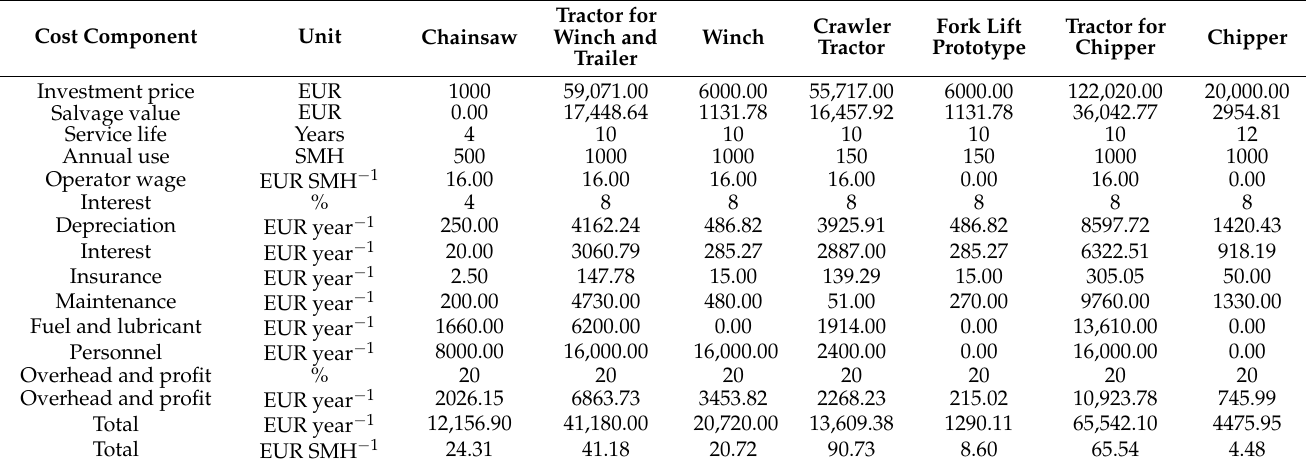
Table 1. Components of cost calculations for the machines. SMH refers to scheduled machine hour, inclusive of delays.